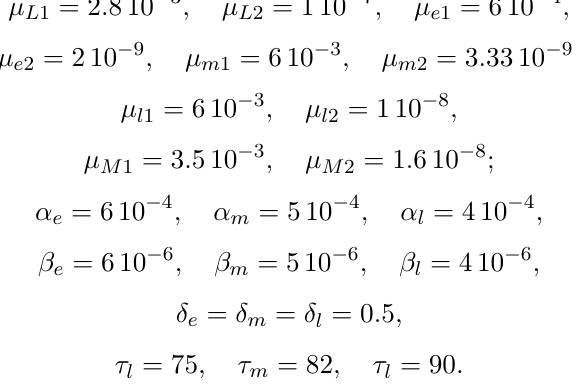
Fig. 4. Early juveniles vs. t for 41